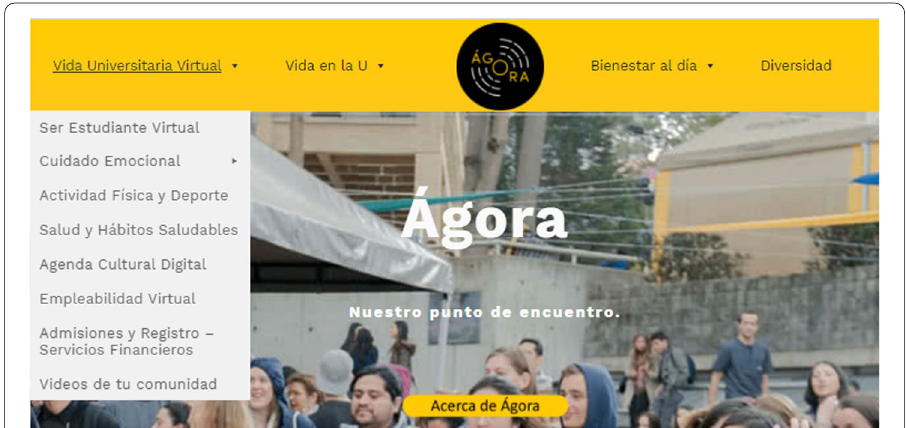
Fig. 12 Menu for students in "virtual university life" from http:// agora. unian des. edu.